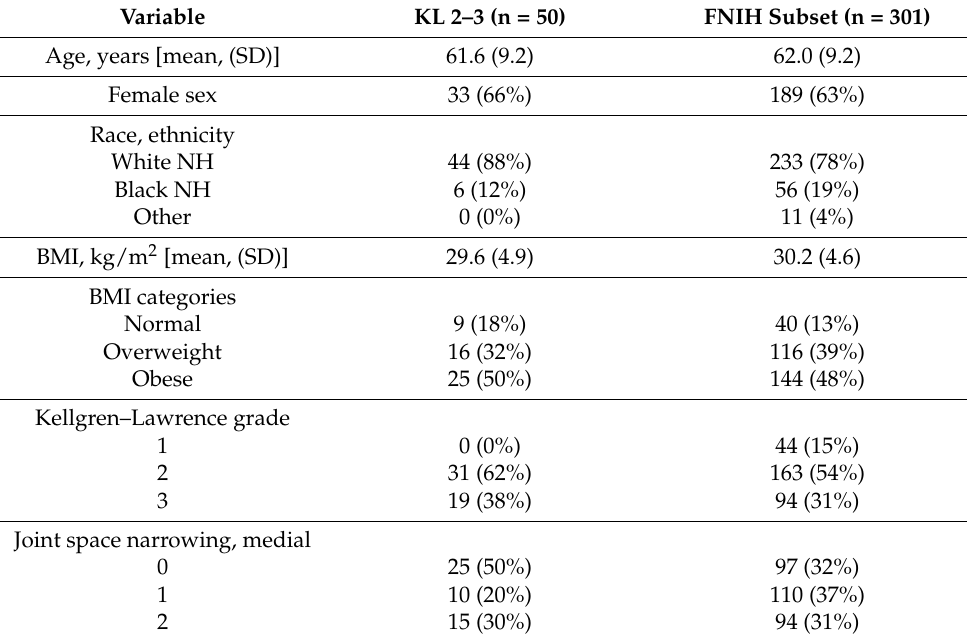
Table 1. Baseline participant and knee